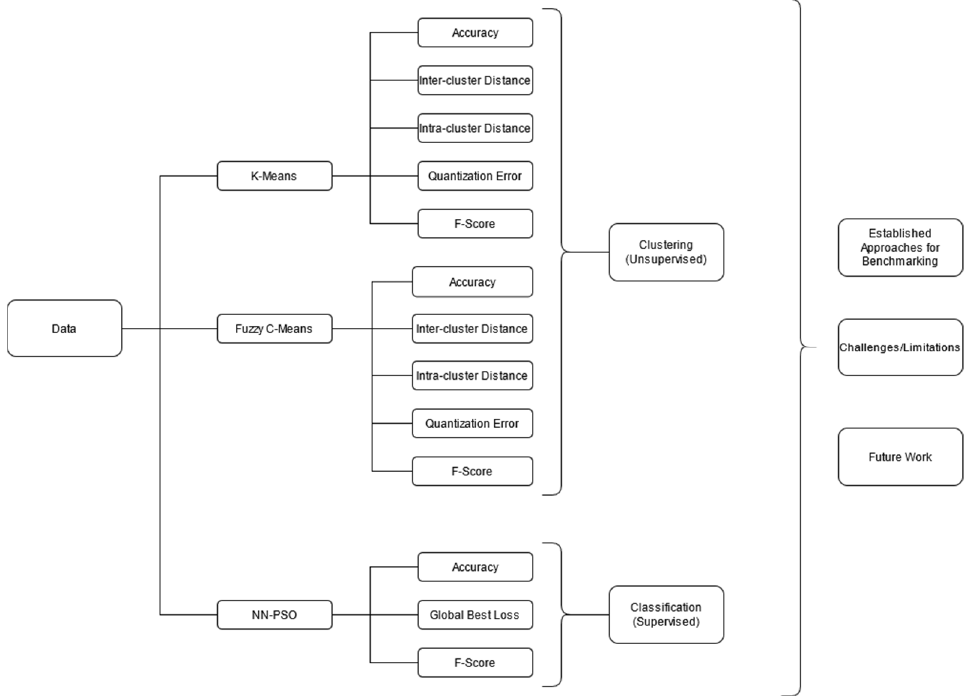
Figure 1. Organization of the paper.